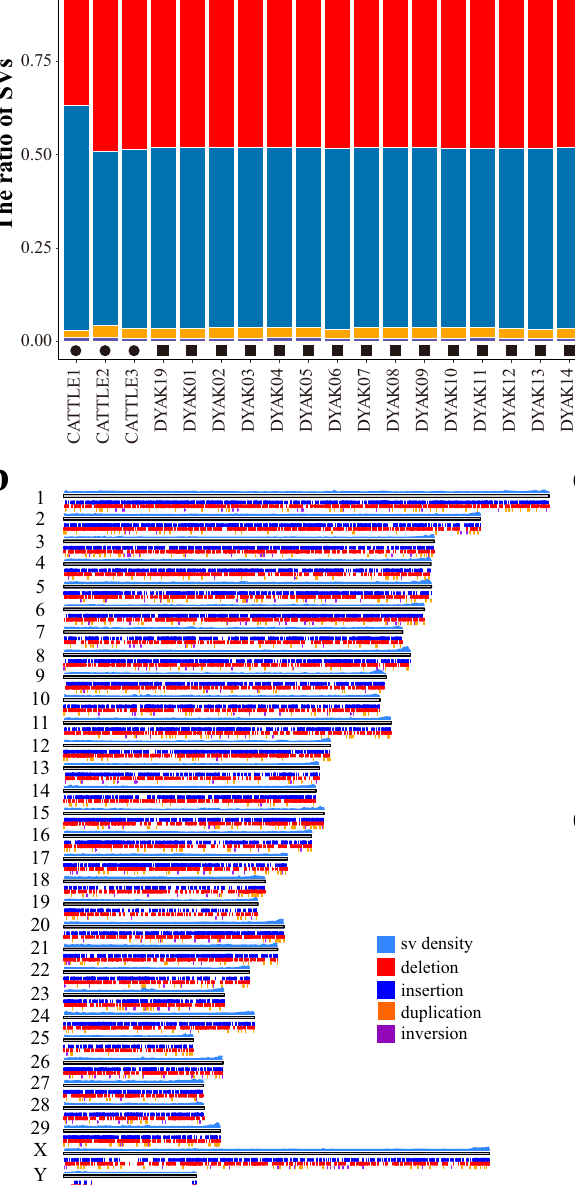
Fig. 1 | Detection and characterization of structural variants (SVs) in yak and cattlegenomes.a StackedbargraphshowingthenumberandtypeofSVfromthe 29individuals. b The chromosomallandscapeofSVs. c The histogramshowingthe number of SVs counted from all SVs located in exon, intron, intergenic, UTR,